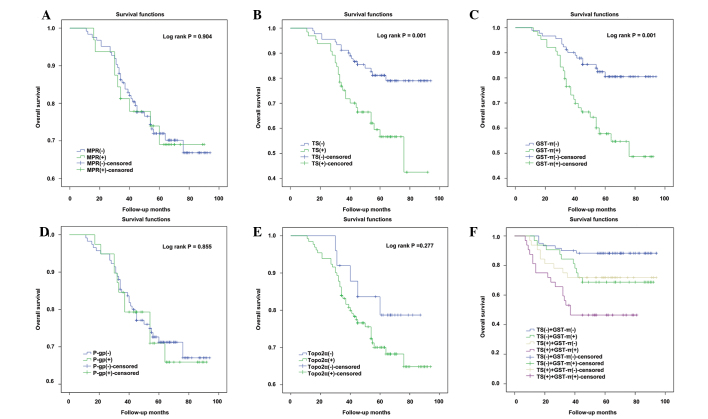
Analysis of the correlations between the five multidrug resistance proteins (A) MRP (B) TS (C) GST-π (D) P-gp (E) Topo2α and (F) combined expression of TS and GST-π and overall survival. Patients with positive TS and GST-π expression exhibited a significantly shorter overall survival time than patients with negative expression for the two proteins. MRP, multidrug resistance-related protein; TS, thymidylate synthase; GST-π, glutathione-S-transferase; P-gp, p-glycoprotein; Topo2α, topoisomerse2α.